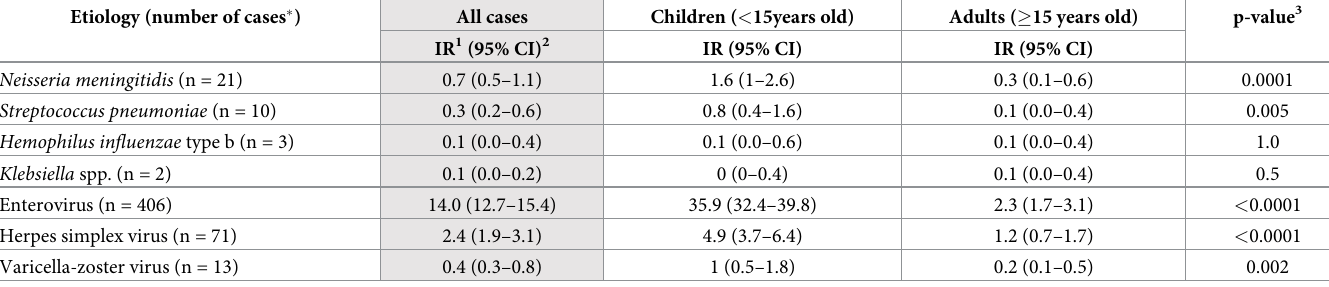
Table 1. Incidence rates of encephalitis/meningitis per 100,000 population by etiology in children and adults. Etiology (number of cases �